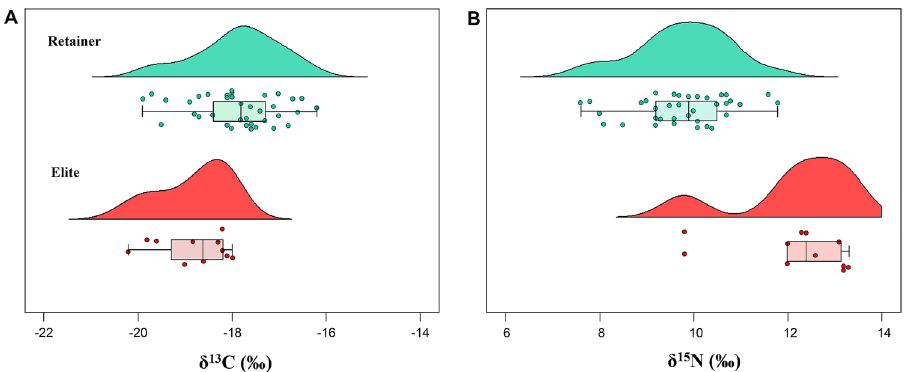
Figure 3. Raincloud plots showing the stable carbon ( A ) and nitrogen ( B ) isotope values between elites and retainers from the Imdang burial mounds. There are significant differences in both δ 13 C ( P < 0.0001) and δ 15 N ( P < 0.0001) values between elites and